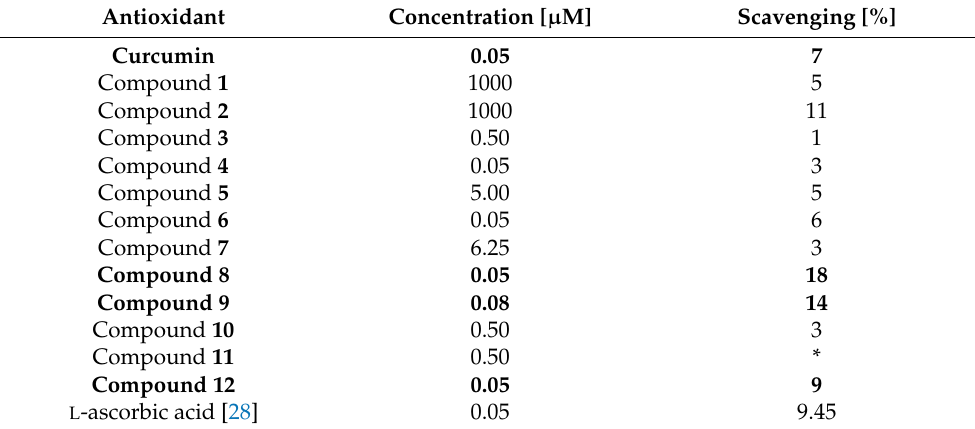
Table 1. The values of percent superoxide anion scavenging by curcumin and its derivatives. Antioxidant Concentration [ µ M] Scavenging [%]